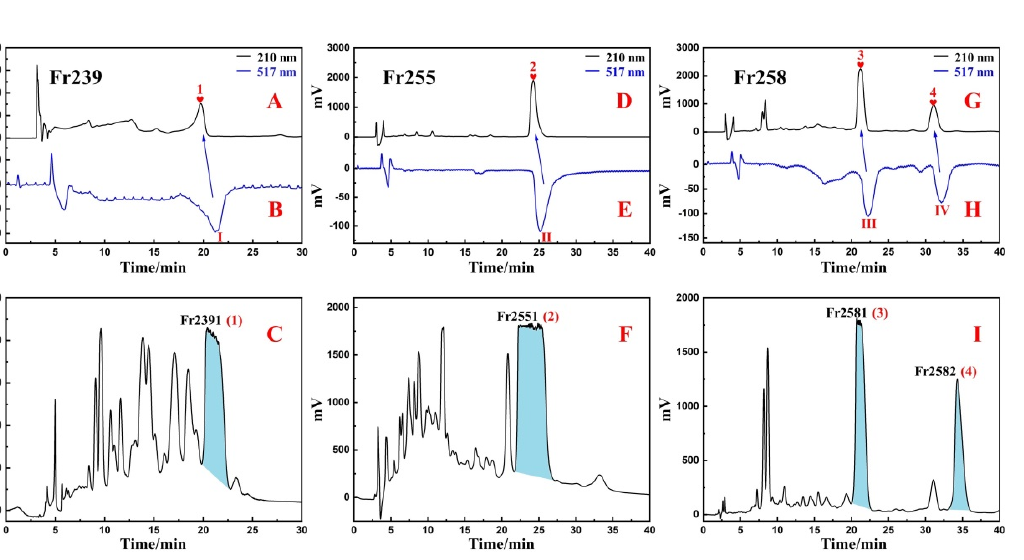
Figure 5. Optimized analytical chromatograms of fractions Fr239, Fr255, and Fr258, acquired at a wavelength of 210 nm, after separation on a Kromasil 100 ‐ 5 Phenyl analytical column ( A , D , G , respectively). The HPLC was performed at a flow rate of 1.0 mL/min, using a column temperature of 30 °C, with 0.1% v / v trifluoroacetic acid in water and acetonitrile (ACN) as mobile phases A and B, respectively, and with the following gradients: 0–30 min with 5% B, 0–40 min with 20% B, and 0–40 min using 17% B. The scavenging profile of 1,1 ‐ diphenyl ‐ 2 ‐ picrylhydrazyl (DPPH) radicals ( B , E , H ), acquired at 517 nm using a flow rate of 0.8 mL/min for the DPPH solution. Preparation chromato ‐ grams of fractions Fr239, Fr255, and Fr258 after separation on a Kromasil 100 ‐ 5 Phenyl preparative column ( C , F , I , respectively).